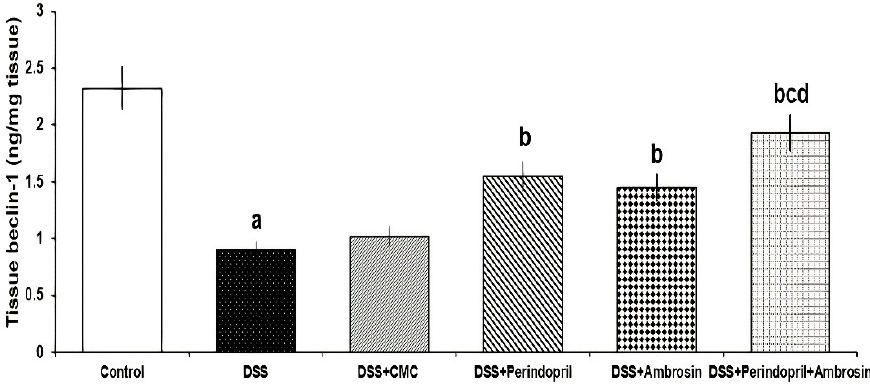
Figure 3. Effect of perindopril with or without ambrosin on beclin-1 and LC3-II levels in the colonic tissues of DSS-treated mice (Mean ± SD); where “a” denotes significant vs the control group ( p -value less than 0.05); “b” denotes significant vs DSS group ( p -value less than 0.05); “c” denotes significant vs DSS + perindopril group (p-value less than 0.05); “d” denotes significant vs DSS + ambrosin group ( p -value less than 0.05). 3.7. Effect of Perindopril and/or Ambrosin on Caspase-8 and Bcl-2 Levels in the Colonic Tissues of DSS-Treated Animals Caspase-8 levels were elevated with the administration of DSS together with a sig- nificant decrement in Bcl-2 levels relative to the control untreated group. These effects were reversed in mice treated with perindopril with or without ambrosin, but DSS mice treated with the perindopril/ambrosin combination exhibited the most favorable re- sponse. However, CMC administered to DSS mice did not seem to have the ability to sig- nificantly affect either caspase-8 or Bcl-2 levels relative to mice treated with DSS alone (Figure 4).